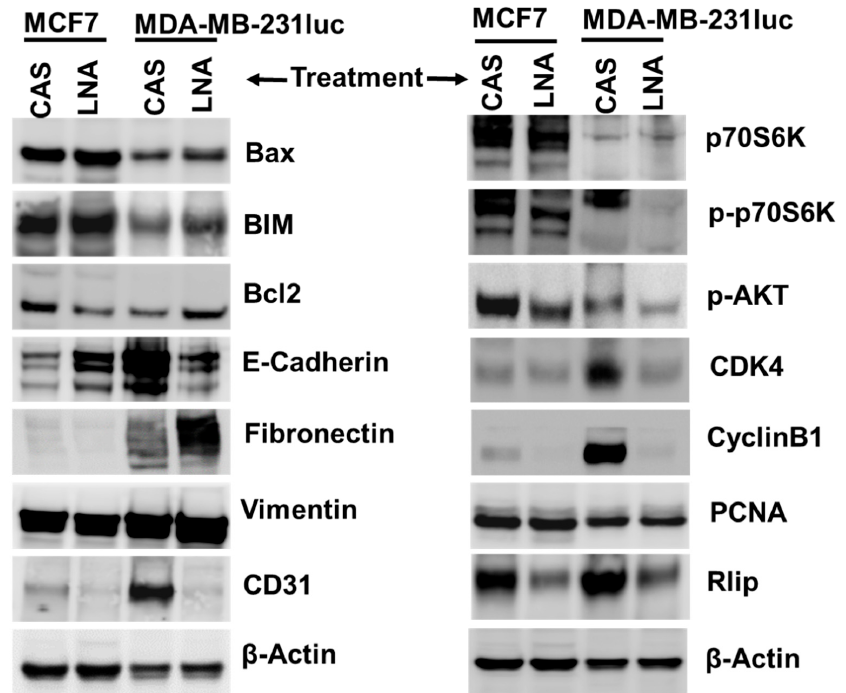
Figure 8. Effect of Rlip depletion with Rlip-LNA on the levels of cell survival, proliferation, apoptosis, and di ff erentiation marker proteins in MCF7 and MDA-MB-231luc breast cancer xenograft tumors. Western blots from lysates of tumors collected at study endpoints showing apoptosis, cell survival, proliferation, and differentiation marker proteins in MCF7 and MDA-MB-231luc tumor tissue lysates after Rlip-LNA treatment. Representative Western blots are shown in the figure. β -actin was used as a loading control.